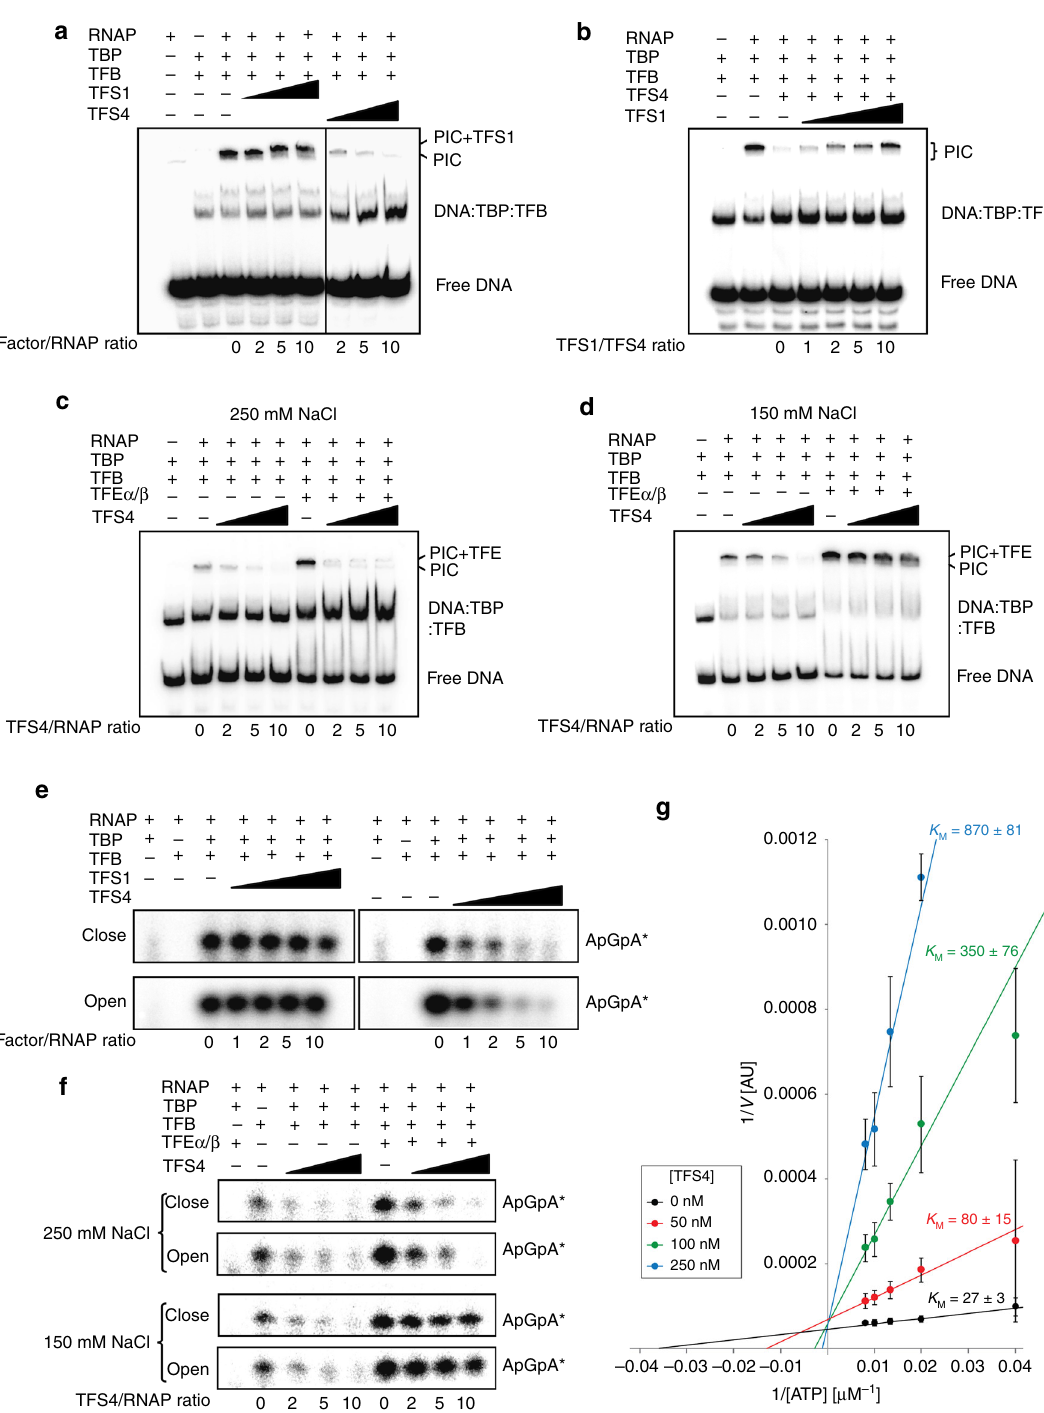
Fig. 3 TFS4 inhibits pre-initiation complex formation and abortive transcription. a Electrophoretic mobility shift assays (EMSAs) with the minimal archaeal PIC complex (SSV1-T6 promoter DNA, TBP, TFB, RNAP) in the presence of TFS1 or TFS4. b Increasing amount of TFS1 can rescue the formation of the minimal archaeal PIC pre-incubated with 100 nM TFS4. c , d TFE α / β mitigates the inhibition of PIC formation by TFS4 under low salt (150 mM) ( d ) but not under high salt concentration (250 mM) ( c ). e Abortive transcription assays measuring the addition of [ α 32 P]-ATP to the dinucleotide primer ApG on homoduplex (close) and heteroduplex (open) SSV1-T6 promoter template in the presence or absence of TFS1 or TFS4. f TFE α / β mitigates the inhibitory activity of TFS4 on addition of [ α 32 P]-ATP to the dinucleotide primer ApG under low salt (150 mM) (lower panel) but not under high salt concentration (250 mM) (higher panel). g Double reciprocal plots showing abortive initiation versus substrate NTP concentration in the absence or presence of TFS4. Error bars represent standard deviation from three technical